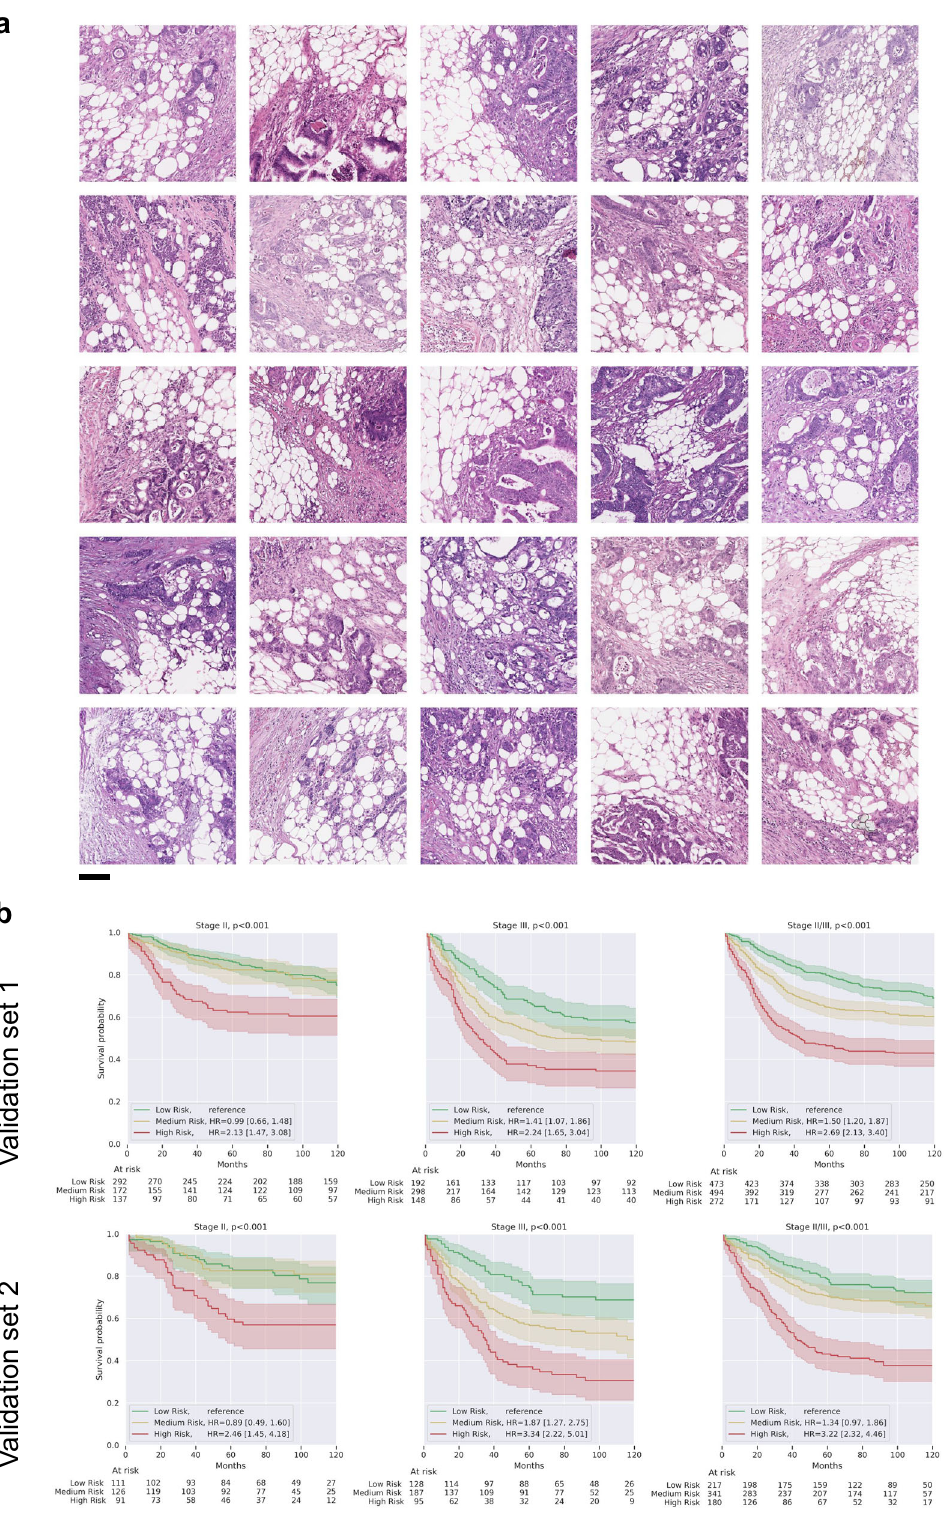
Fig. 3 Visualizations and survival analysis of the clustering-derived feature with the highest DLS-predicted risk score (tumor-adipose feature, TAF). a Additional sample patches of the TAF cluster, each from a unique case. Scale bar indicates 0.1 mm. b Kaplan Meier curves on both validation sets for patients strati fi ed by quantitation of TAF. These curves were generated following the same procedure as in Fig. 1. In stage II cases, the deviation in at-risk counts from the quartile marks for the low-risk and medium-risk groups are because many stage II cases did not contain any